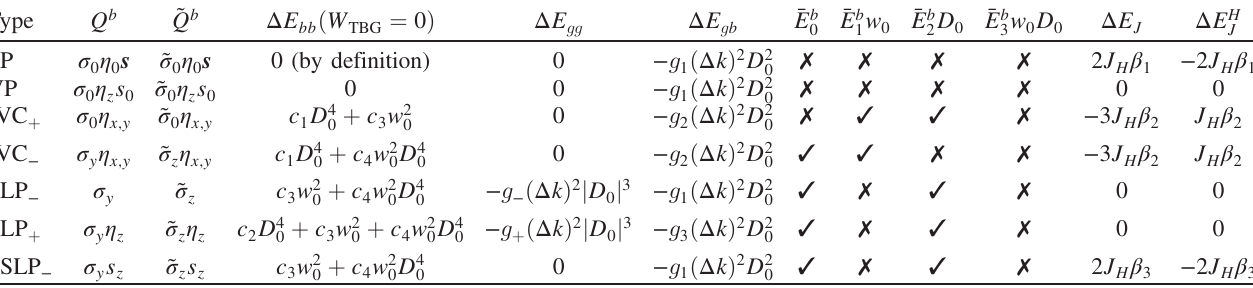
TABLE III. Summary of the different energetic contributions, as discussed in Sec. V, for the candidate orders in Table II when tuning D 0 ¼ 0 ). By construction, the energies are identical for the respective Hund ’ s away from the chiral-flat-decoupled limit ( w 0 ¼ W TBG ¼ 0 Þ is the change of energy relative to SP phase coming from the modifications of W partners and are hence omitted. Here, Δ E bb ð TBG ¼ 0 ). As indicated in the column labeled the form factors in the TBG-like bands when turning on w 0 and D 0 in the flat limit ( W TBG ¼ Δ E , only the SLP states gain energy by ordering in the graphenelike bands immediately when D 0 ≠ 0 . In all cases, D 0 ≠ 0 leads to gg (cid:2) mixing between the bands with energetic gain, as listed in the chiral limit w 0 ¼ 0 in the column Δ E . Here, Δ k is the linear size of the gb ¯ E b fraction A of the MBS where ordering in the graphenelike bands and mixing take place. The four columns with indicate which of (cid:2) j the four contributions to the TBG dispersion in Eq. (2.6) can lower the energies to second order in W . Finally, in the last columns, we TBG list the energy change associated with a finite value of Hund ’ s coupling in Eq. (3.16) for the respective state ( Δ E ) and its Hund ’ s partner J ; g ; g ; β > 0 and explicit expressions can be found in the ( Δ E H ), if it exists, in the chiral-flat-decoupled limit. All coefficients obey c j j j (cid:2) J Supplemental Material [59] Sec.